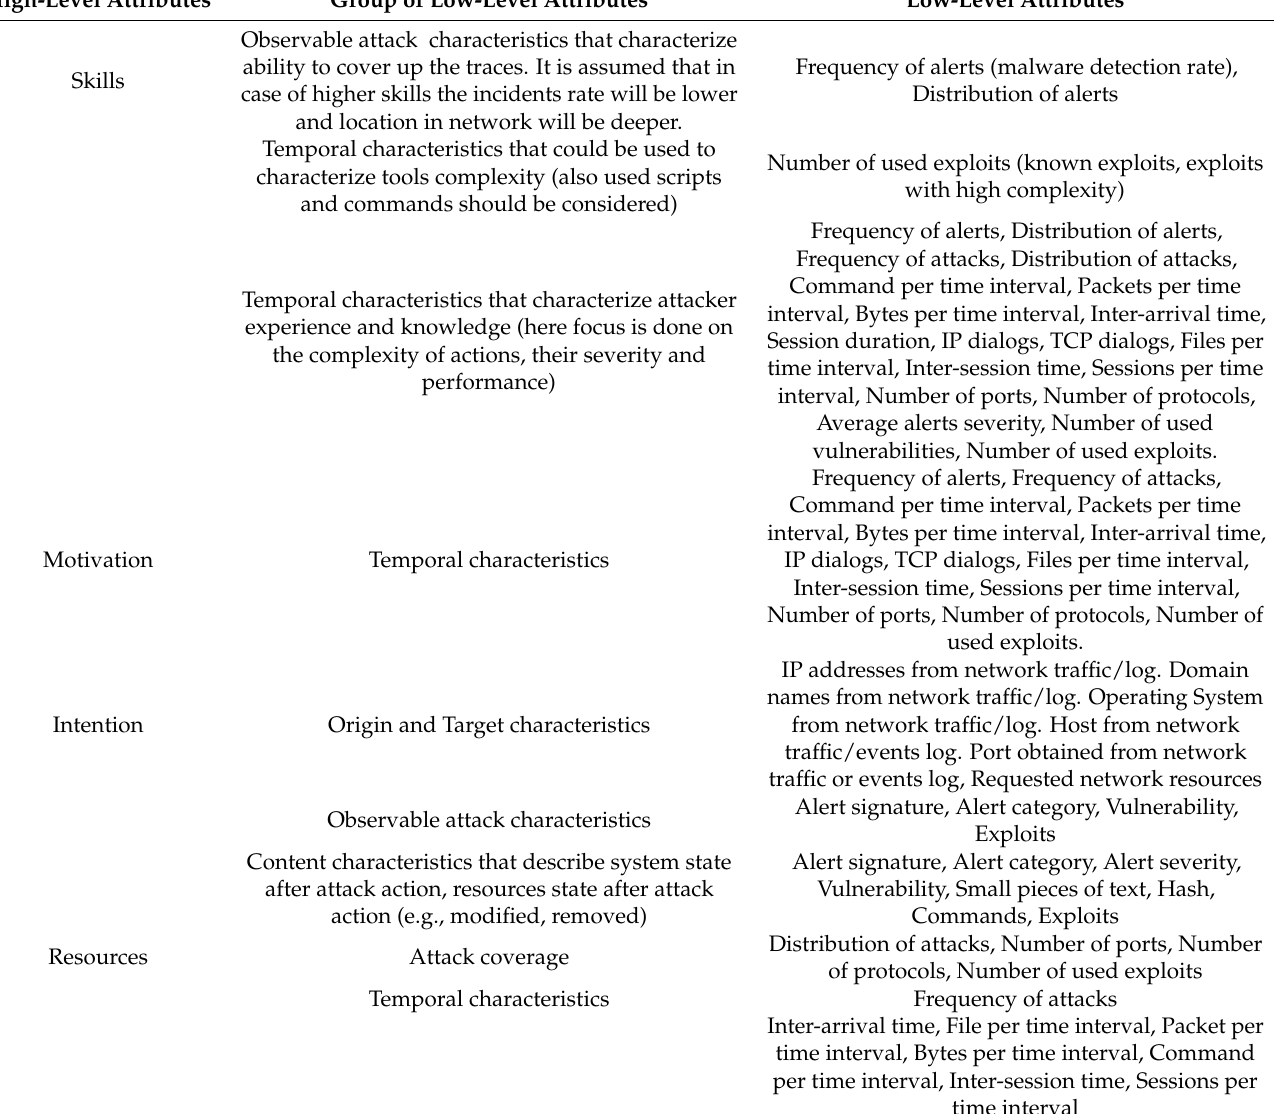
Table 2. Mapping of the low-level attacker attributes to high-level